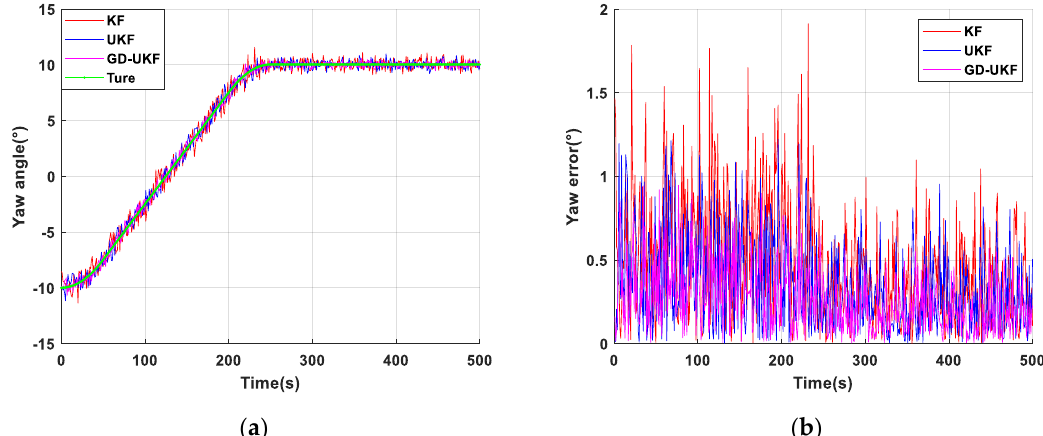
Figure 8. Yaw angle test of support attitude sensing system: ( a ) yaw angle estimation based on three methods; ( b ) yaw error of three methods.